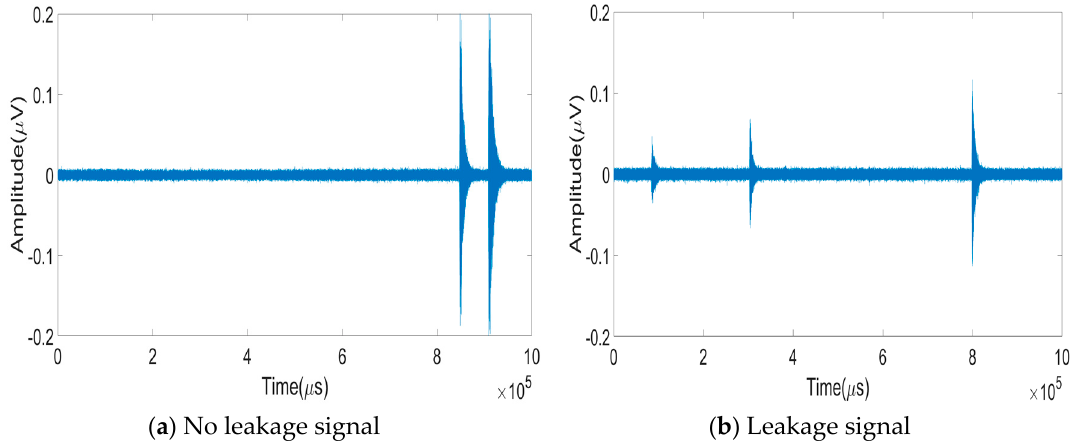
Figure 5. Collected signals: ( a ) no leakage signal and ( b ) leakage signal.